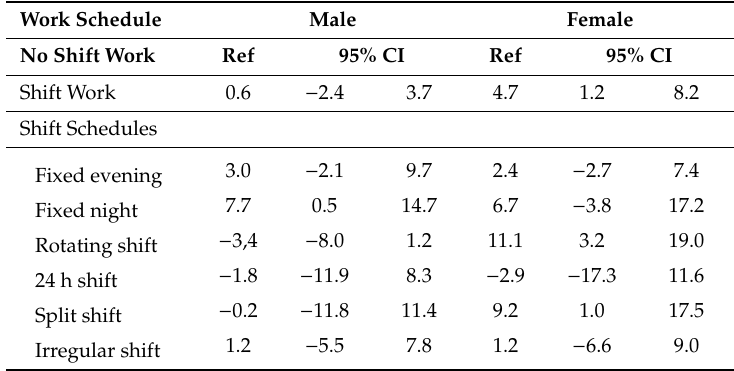
Table 3. Gender-stratified health-related productivity loss (HRPL) due to shift work and various shift schedules in the Korean working population (Unit: percent